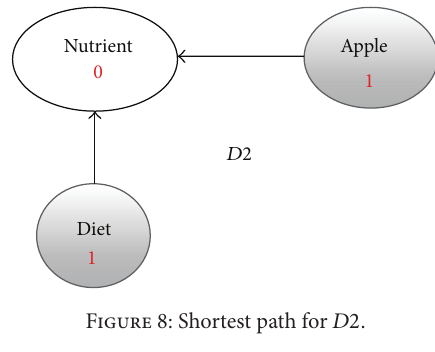
Figure 8: Shortest path for 𝐷2 .